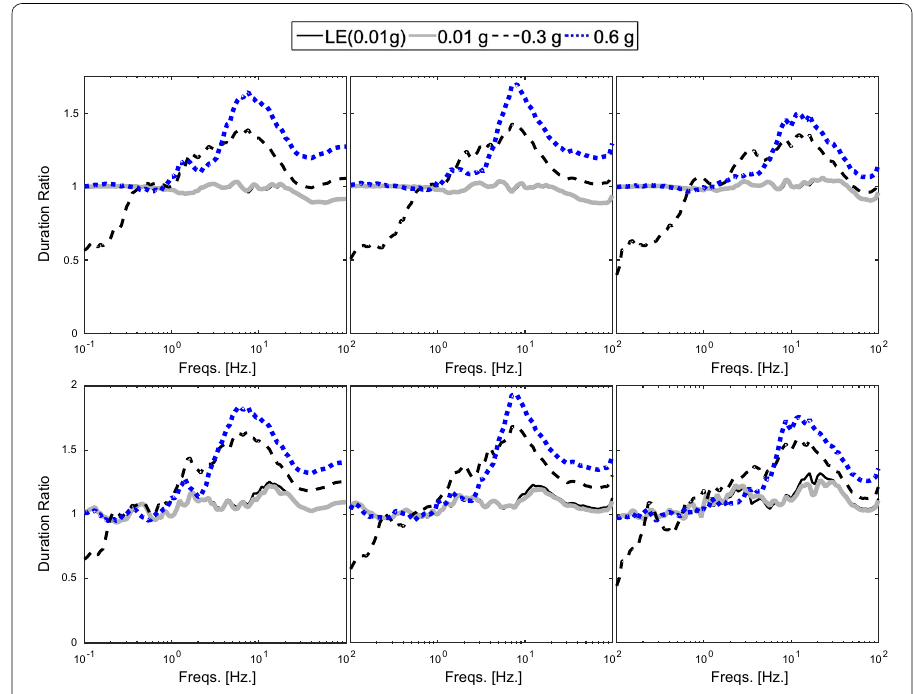
Fig. 9 Duration ratios for the SCH site (top figures) and the CC site (bottom figures) for all levels of intensity and input spectra. Left to right: results corresponding to the NRC, NGA and NUC